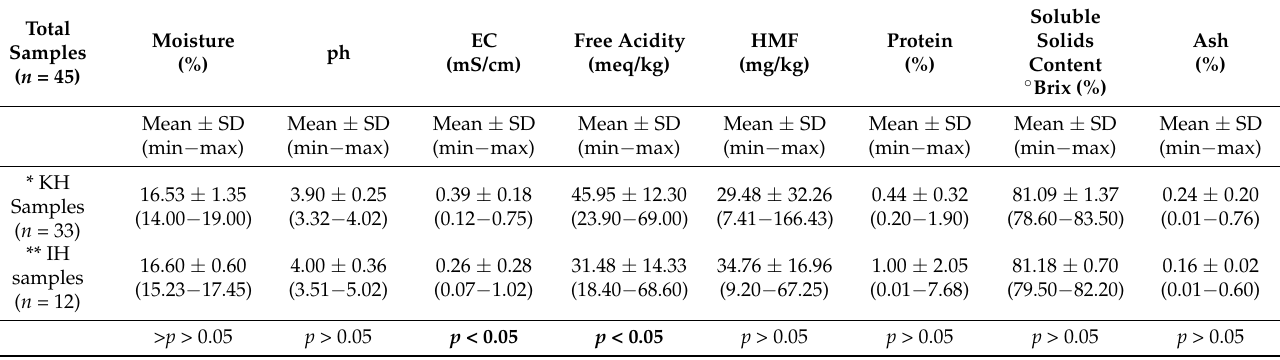
Table 4. Physicochemical parameters of Kosovo’s and imported honey